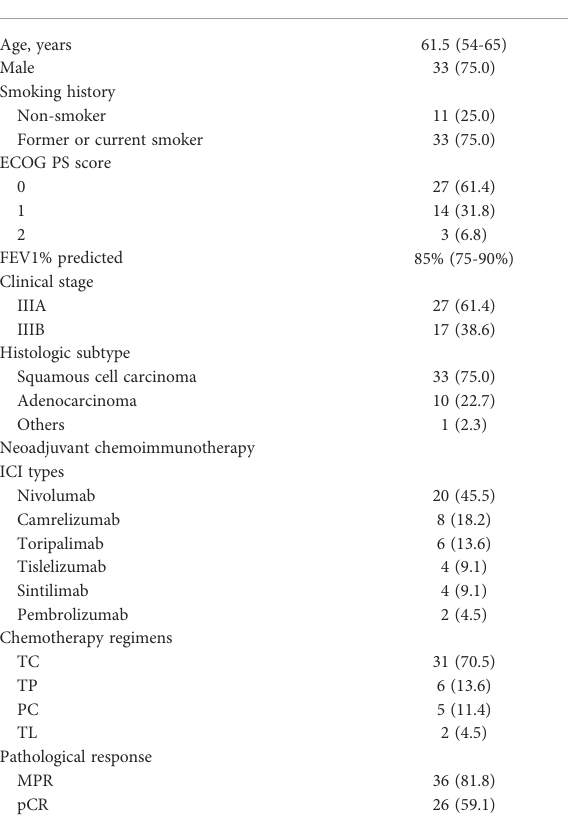
TABLE 1 Baseline characteristics of patients and pathological responses to neoadjuvant chemoimmunotherapy.